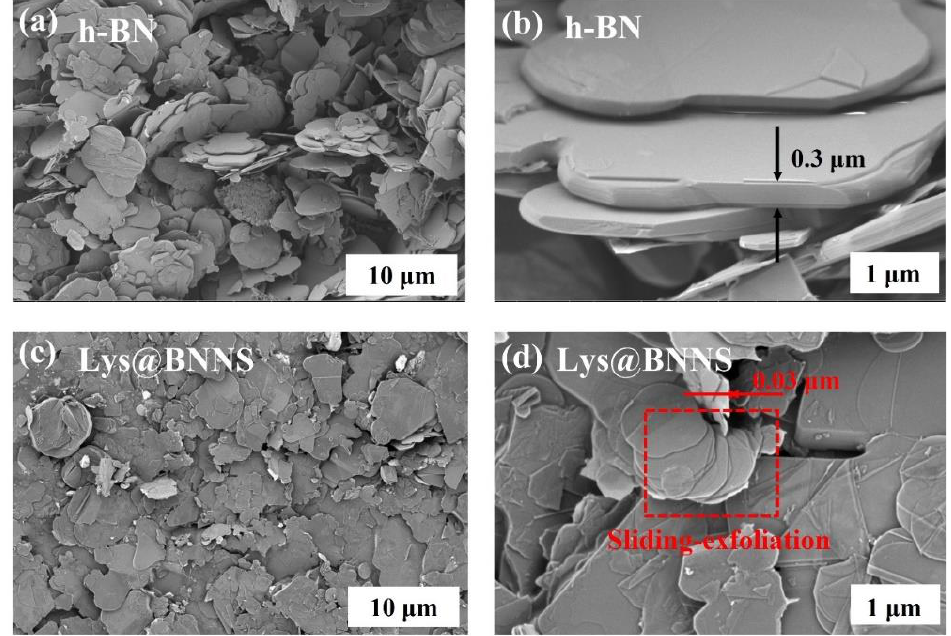
Figure 3. SEM images of ( a , b ) h-BN and ( c , d )